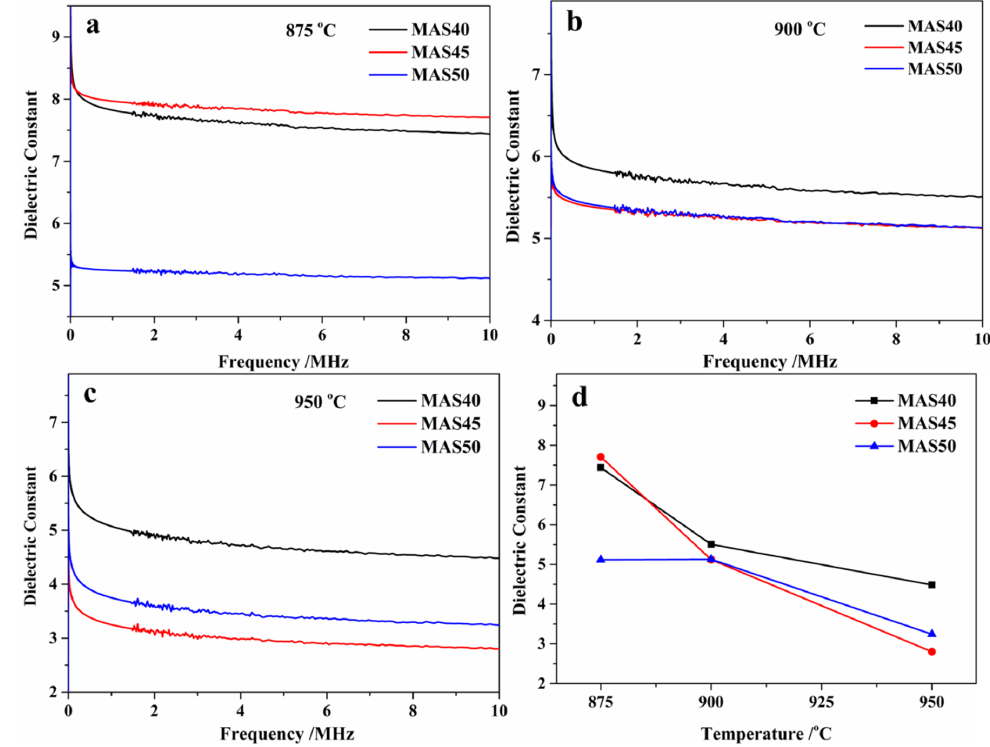
Figure 5. Dielectric constants of glass-ceramics prepared at different sintering temperatures versus frequency ( a – c ) in the range 20 Hz–10 MHz and versus temperature ( d ) at 10 MHz. In this study, crystallinity, porosity, and chemical composition of the residual glass phase were the main factors determining the dielectric constant of glass-ceramics, but their effects were interrelated and sometimes indivisible, and individual contributions could not be distinguished. According to Figure 2, only the samples sintered at 950 °C indicated the absence of an amorphous band between 20°and 30° (2 θ ), demonstrating that the α -cordierite crystallinity of glass-ceramics sintered at 950 °C was higher than that of other samples. As mentioned before, a higher crystallinity of glass-ceramics re- sults in dielectric constants close to that of α -cordierite. However, the dielectric constants (2.80–4.48) of glass-ceramics sintered at 950 °C were unusually small, indicating that they were mainly affected by the porosity. On the other hand, the dielectric constants (5.12–7.71) of glass-ceramics prepared at 875 °C were mainly dominated by the crystal- linity of α -cordierite. Satisfyingly, glass-ceramics sintered at 900 °C had an expected di- electric constant (5.12–5.51) due to its high density and low porosity, which was ideally close to that of α -cordierite glass-ceramics and better than that of some commercial LTCC substrate materials. The dielectric loss comes from intrinsic and extrinsic loss. The intrinsic loss mainly depends on crystal structure, reifying the interaction between the lattice and the external electric field [40,41]. The extrinsic loss is related to the porosity of structural defects, im- purities, and micro-cracks of the material’s microstructure [42]. The dielectric loss of a material is mainly affected by extrinsic loss because of the lower intrinsic loss of α -cordierite. Figure 6 shows the dielectric loss (a, b, and c) of glass-ceramics prepared in the range 875–950 °C and its dielectric loss (d) at 10 MHz. According to Figure 6, the di- electric loss of glass-ceramics sintered at 875 °C and 900 °C was between 0.010 and 0.018, while that of glass-ceramics sintered at 950 °C was slightly higher, between 0.017 and 0.24. Due to the presence of impurities in tuff and excess MgO, the dielectric loss was